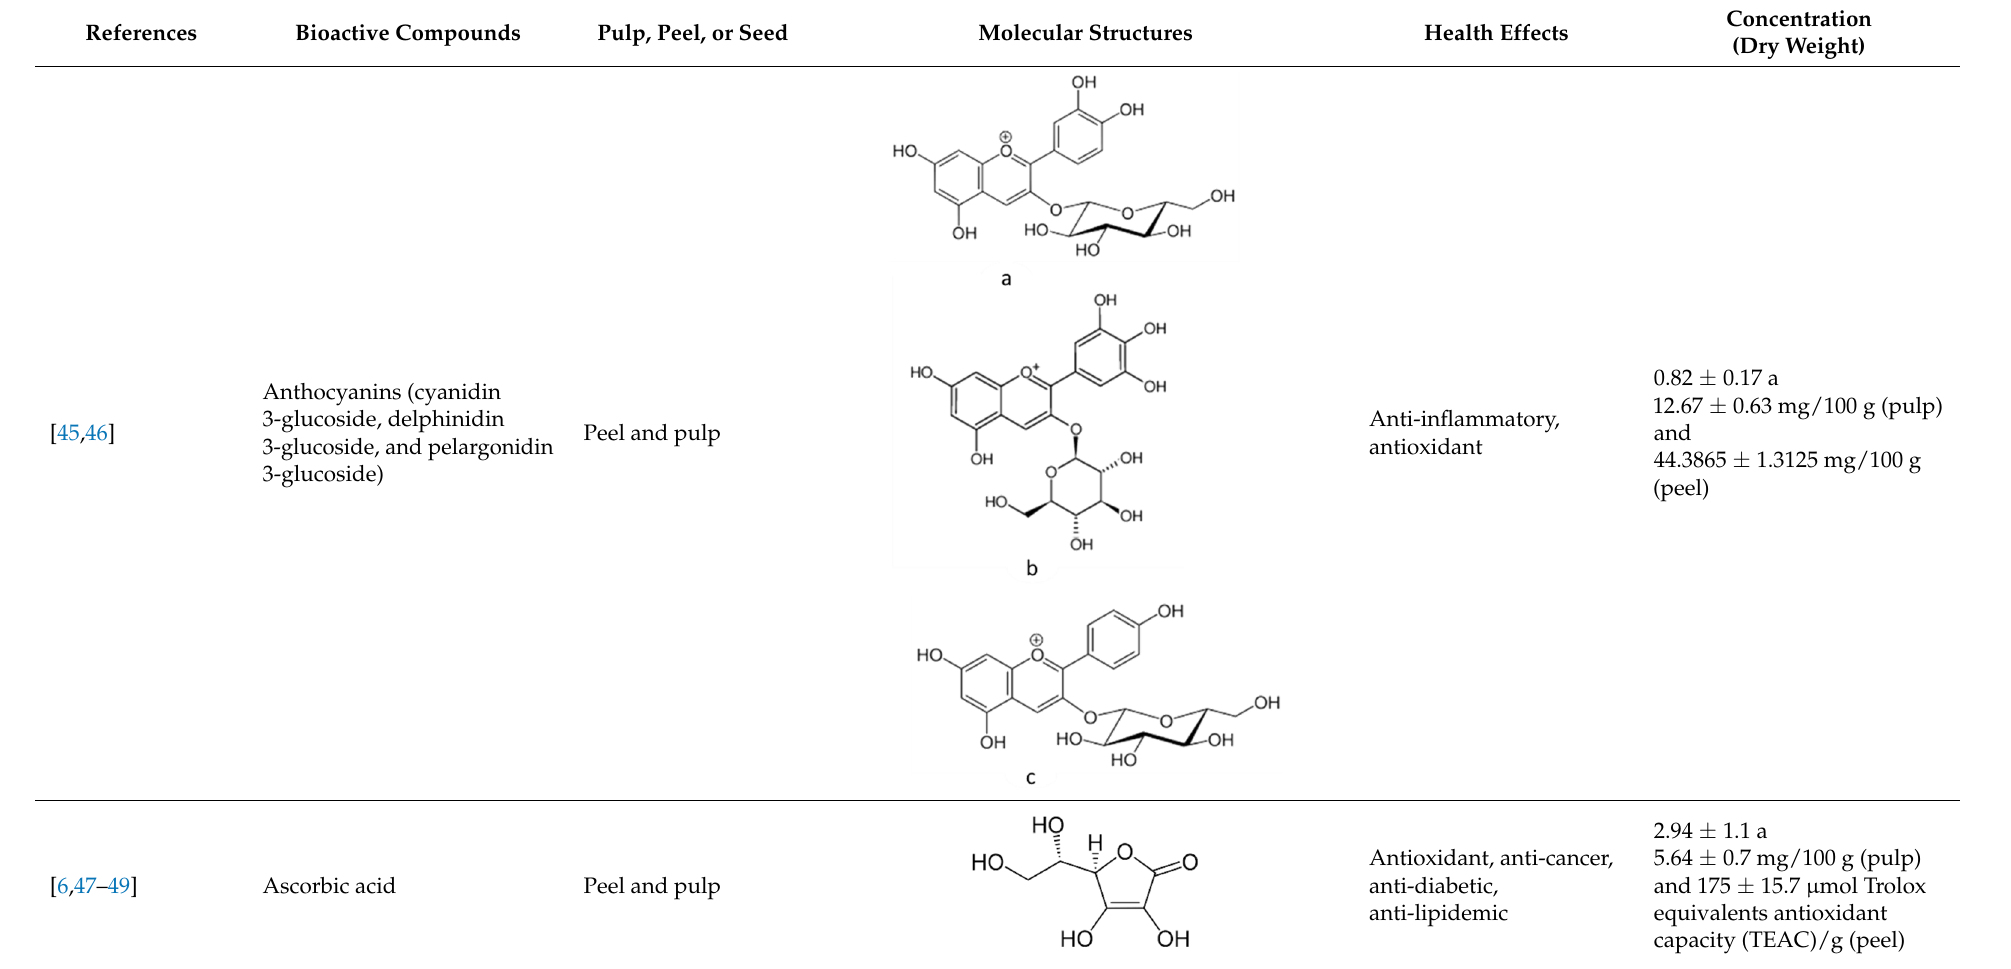
Table 3. Main bioactive compounds of pulp, peel, and seeds of the genus Hylocereus .